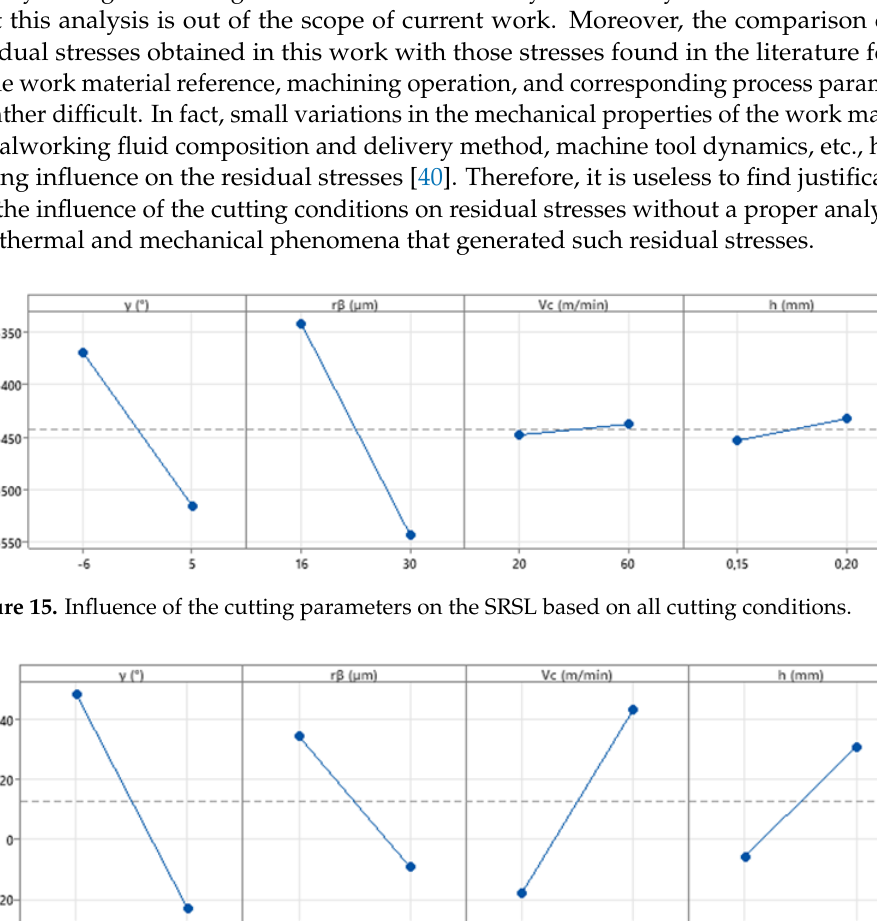
Table 10. Optimal cutting conditions for maximizing the compressive residual stresses. γ n (°)